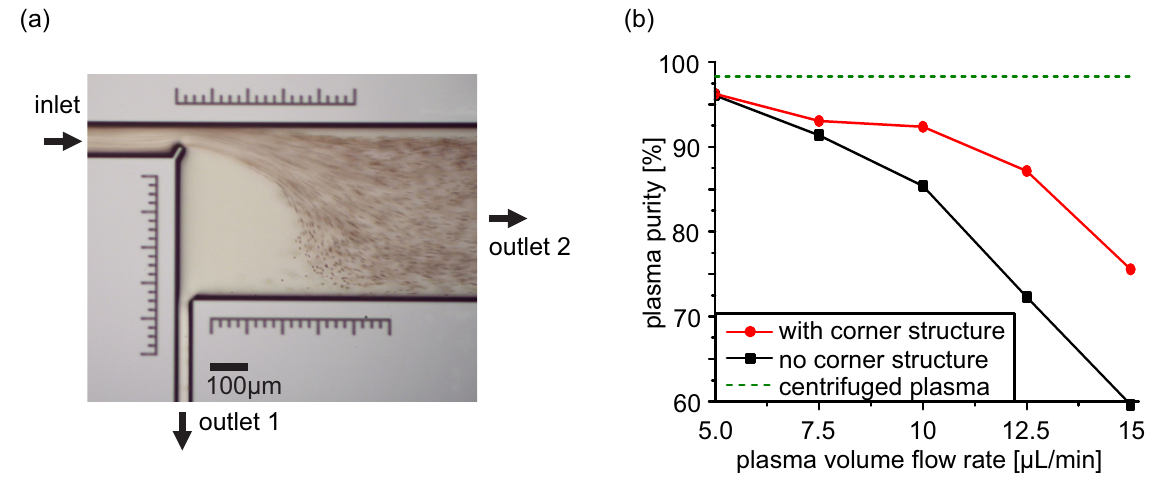
Figure 6. ( a ) Bright-field image of human blood plasma separation experiment at a flow rate of 200 µ L/min. The concentrated blood stream exits at outlet 2. ( b ) Purity of plasma generated by the microfluidic chip with and without corner structure in comparison to centrifuged